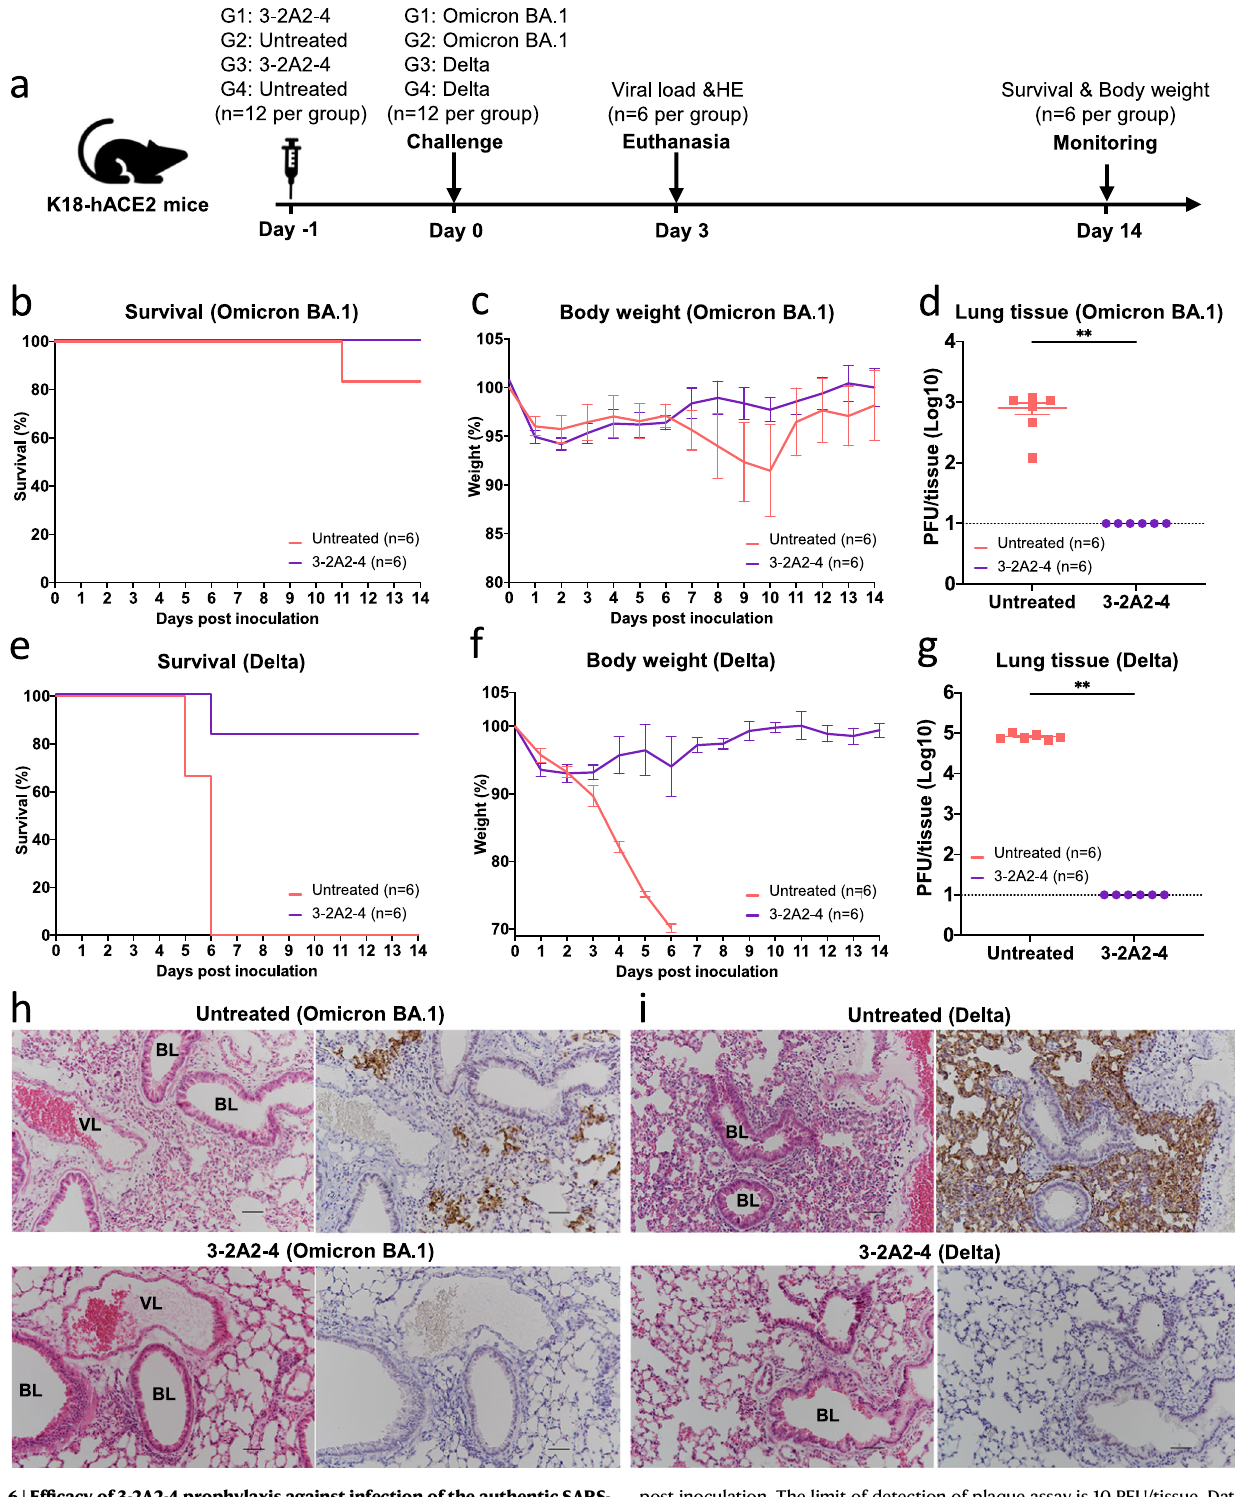
post inoculation. The limit of detection of plaque assay is 10 PFU/tissue. Data are presented as the means±SEM. The differences between 3-2A2-4 group and untreated group are statistically signi fi cant with two-tailed p value=0.0022 (** P <0.01, Mann – Whitney test) in both Omicron BA.1 and Delta challenge. h , i HE and IHC staining of lung tissue from 3-2A2-4-treated or untreated mice at 3 days post inoculation. VL vascular lumen, BL bronchiolar lumen. Scale bars, 50 μ m. Results presented are representatives of each group ( n =6). Source data b – g are provided as a Source Data fi